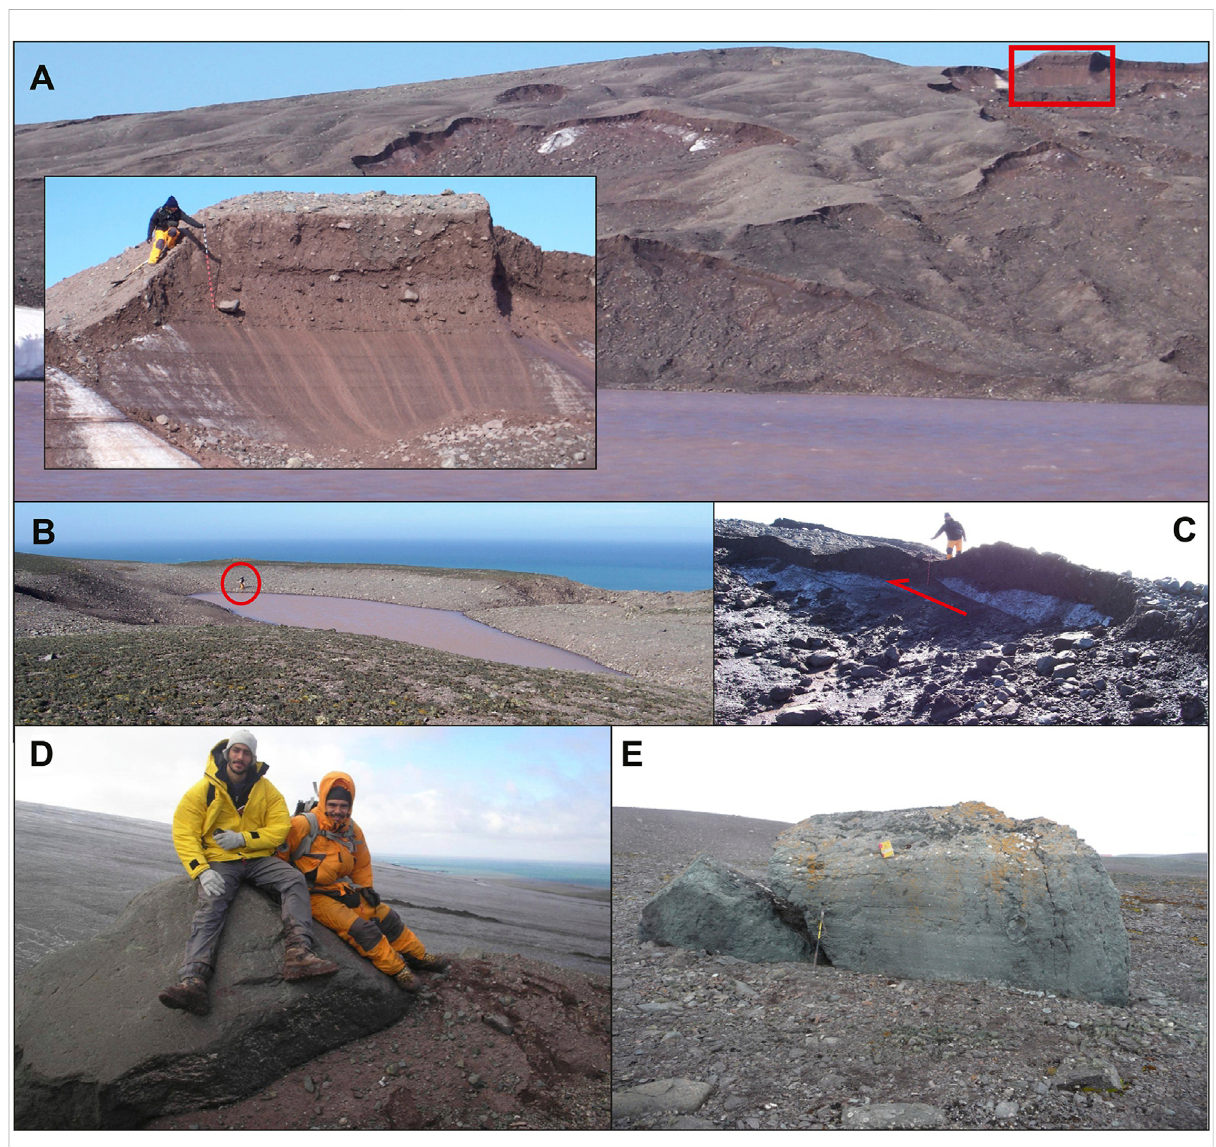
FIGURE 8 The Stranger Point and Three Brothers Hill moraine landform assemblage and inactive Holocene glacial landforms that have collapsed due to thermoerosion. (A) Debris fl owsandslumpsarereworkingthemoraine,showingitsicecore. (B) Apondborderedbyprominentmoraineridges. (C) A moraine thrustin thedirectionof thered arrow and mud fl owsat thefoot of theice-cored moraine. (D) Striated and polished basaltic boulder on the moraine, deposited by thrusting. (E) Polished and striated block in the surroundings of Three Brothers